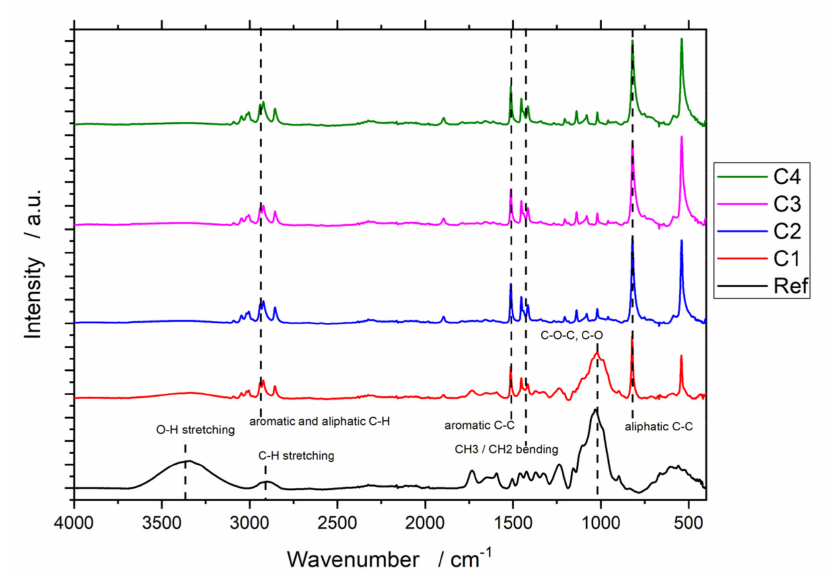
Figure 4. FTIR spectra of coated and uncoated beech